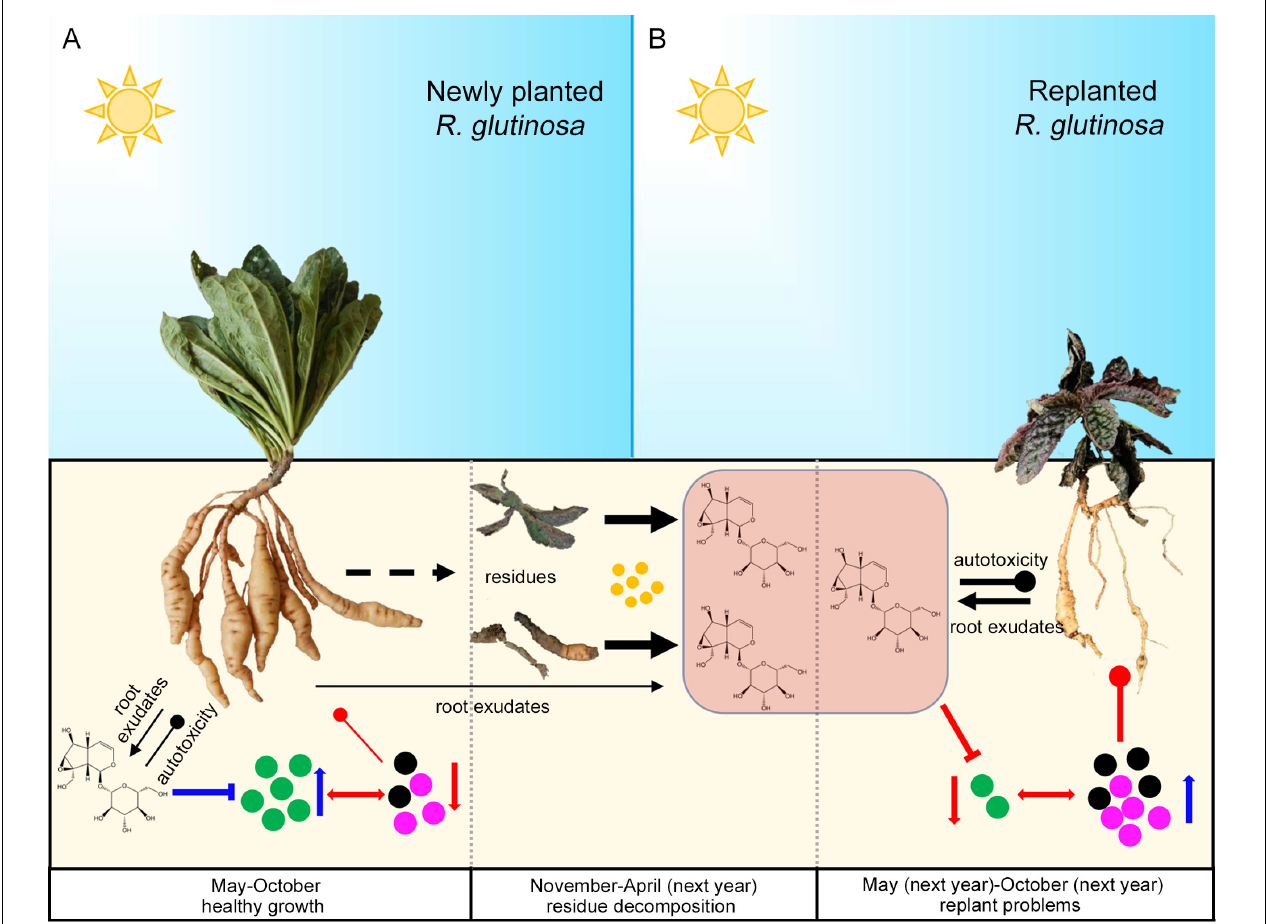
FIGURE 15 | Potential plant-soil feedbacks of R. glutinosa under newly planted (A) and replanted (B) conditions. Newly planted R. glutinosa were commonly cultivated from May to October, and harvested in November. Plant residues were abandoned in the field after harvest, and catalpol were released and accumulated in the soil with the decomposition of residues by soil microbes (yellow color) from November to April of next year. R. glutinosa was replanted in the same field in May and abnormal growth were observed. Green microbes represented the biocontrol agents or plant growth promoting microbes. Black and purple microbes represented the pathogens. Number of the microbes represented their abundance. Suppression and promotion of microbial growth were represented by red and blue arrow, respectively. Autotoxicity was represented by the thickness of black clubs. Pathogenicity was represented by the thickness of red clubs. The promotion and inhibition effects of catalpol on microbe growth were represented by blue and red “T” lines, respectively.